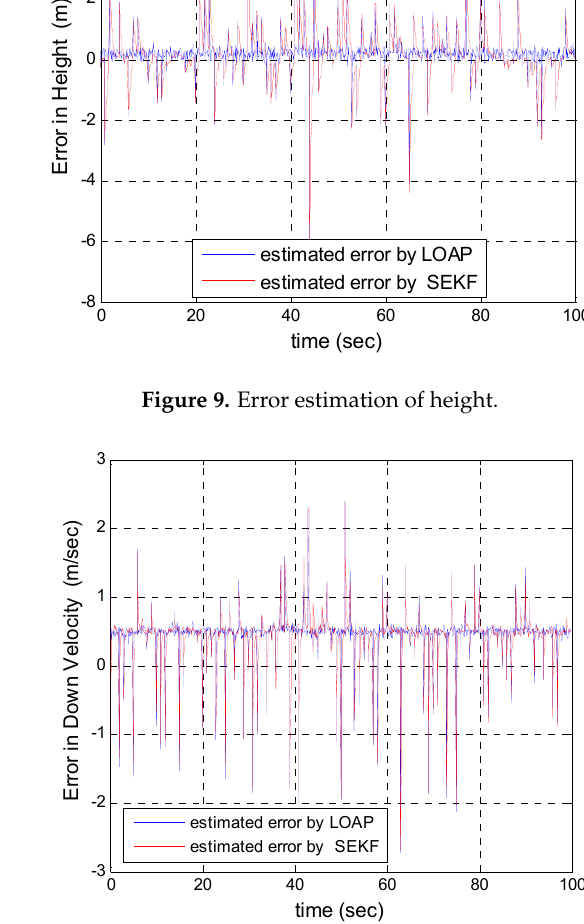
Figure 10. Error estimation of down velocity.